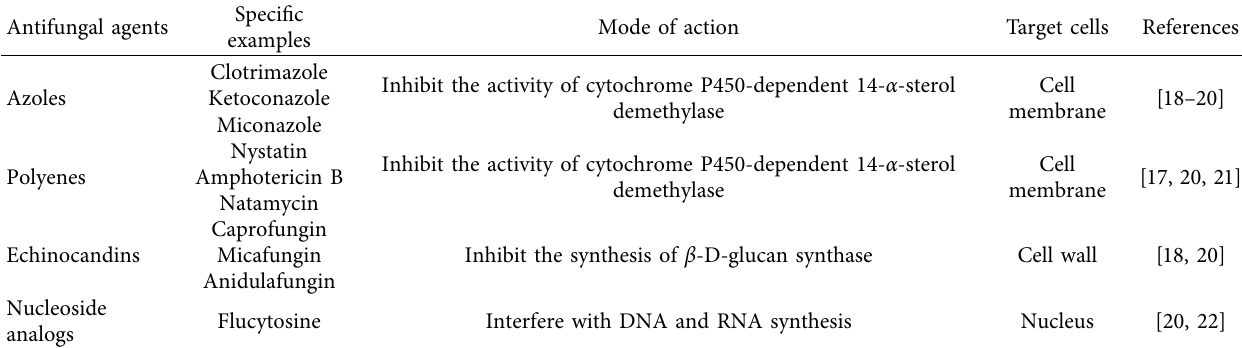
Table 1: Classes of antifungal drugs, their modes of action, and target cells in pathogenic yeasts.